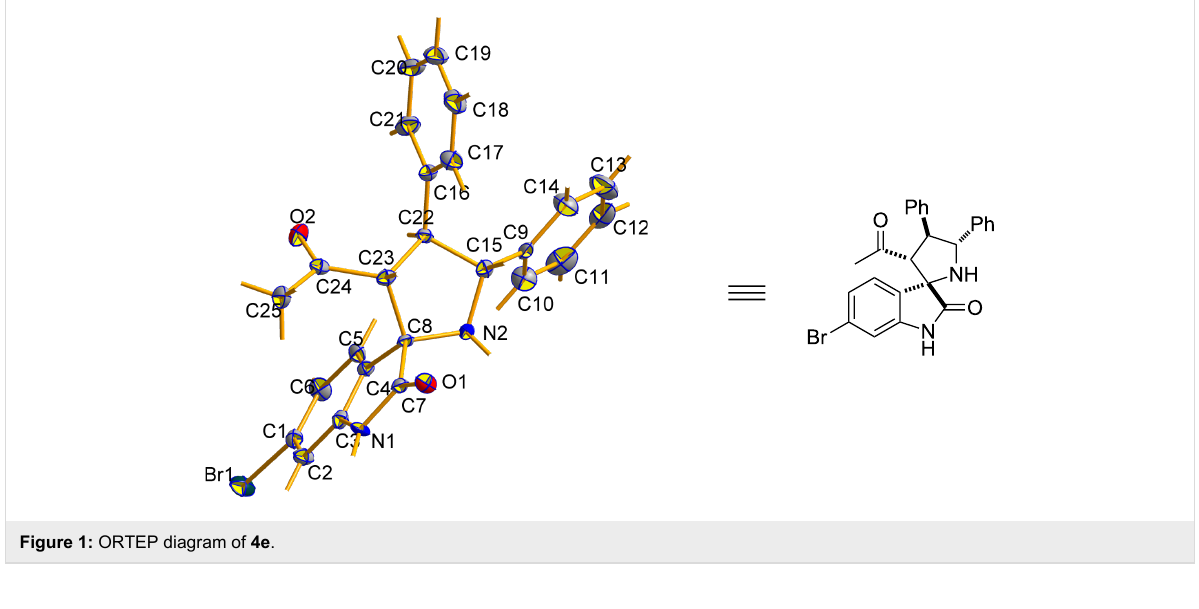
Figure 1: ORTEP diagram of 4e .